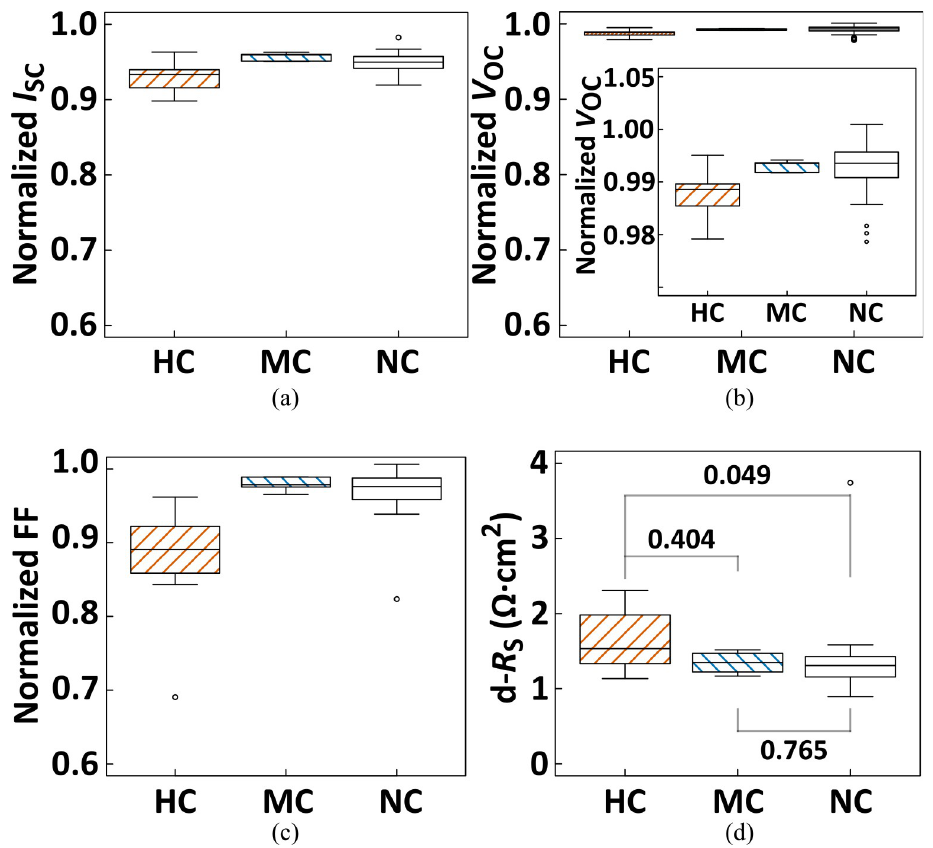
Fig 9. Multicomparison charts for the categorized PV cells on (a) I sc , (b) V oc , (c) FF, and (d) d- R s ( R s determined from dark I–V data). Subfigure (b) with a vertically expanded axis is also shown as the inset. The open circles represent outliers, and the figures in (d) denote the respective p -values in the